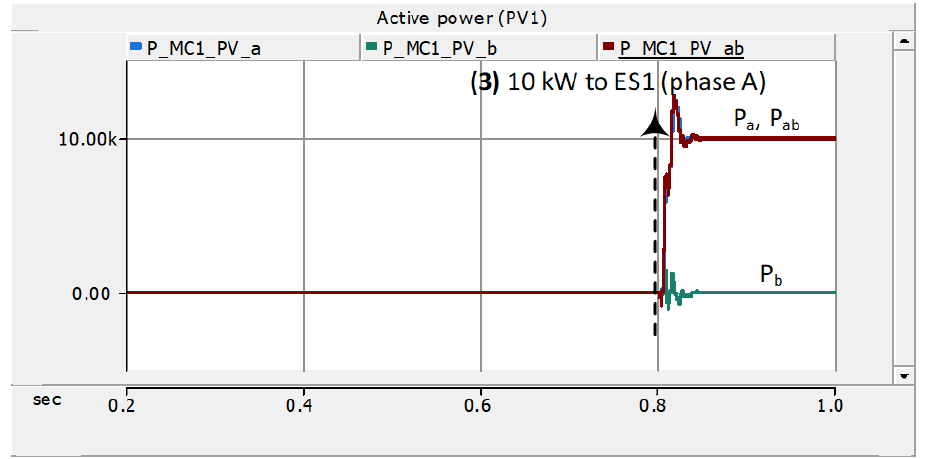
Figure 15. Active power at the secondary side at the wye-wye transformer of MC1. Active power in phase A, B and C are labeled as P a , P b , P c , respectively.